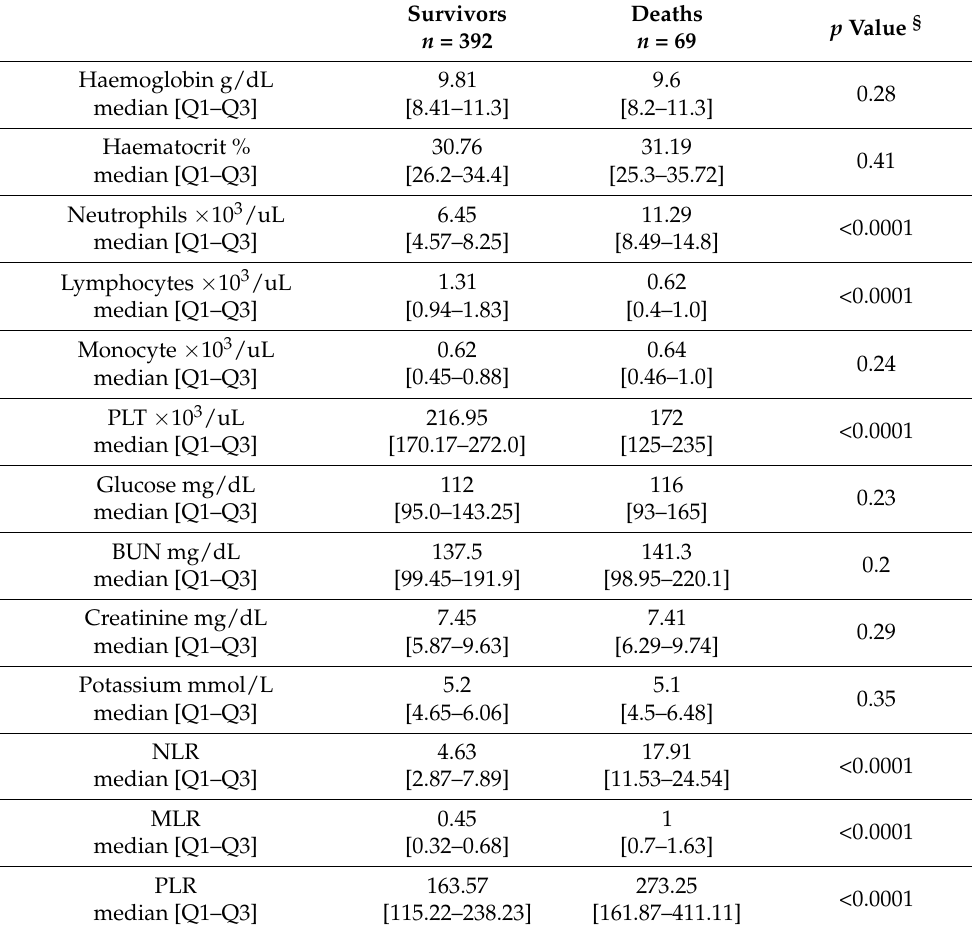
Table 3. Laboratory data of the two sub-groups evaluated according to poor